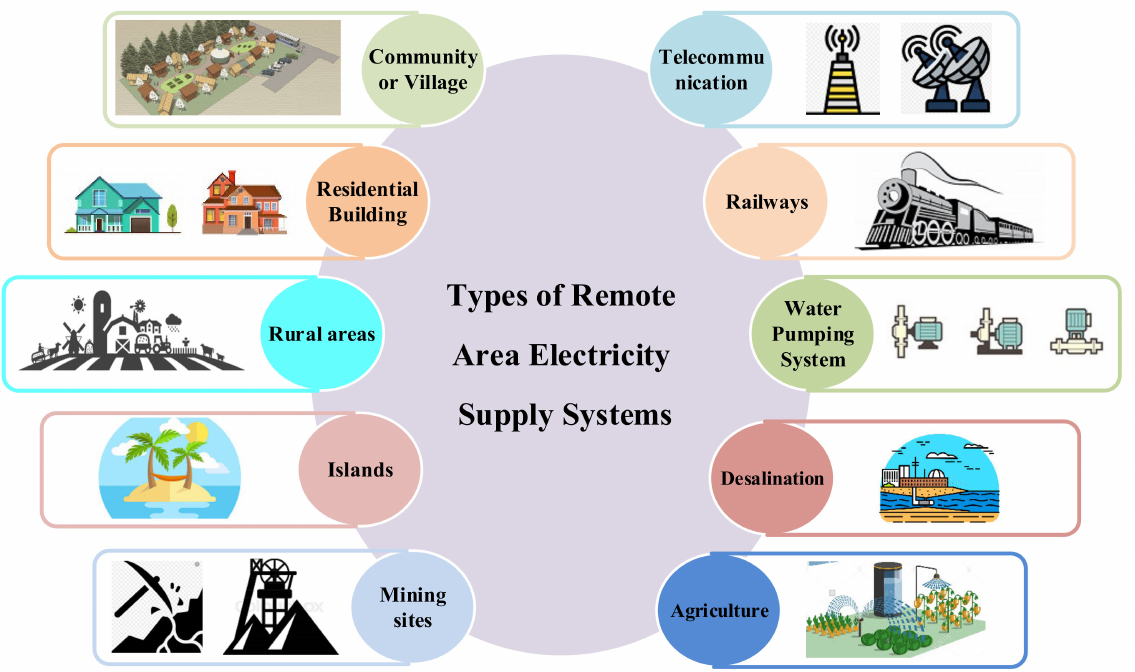
Figure 1. Important sites with the necessity to develop RAES systems.